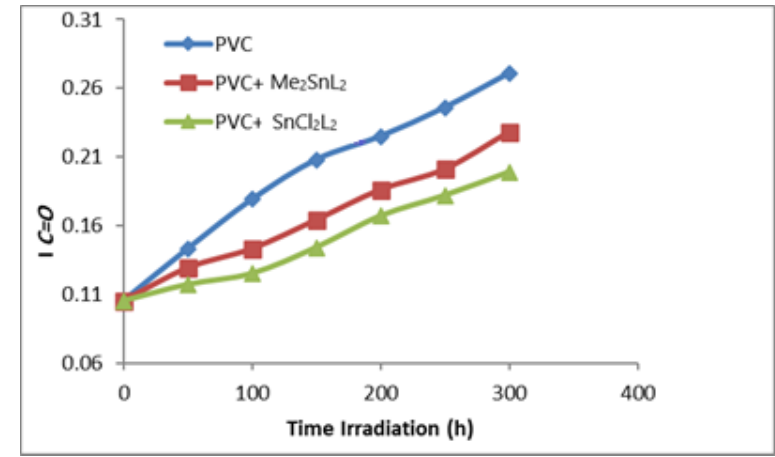
Figure 3. Changes in the I C=O index for PVC films versus irradiation time.